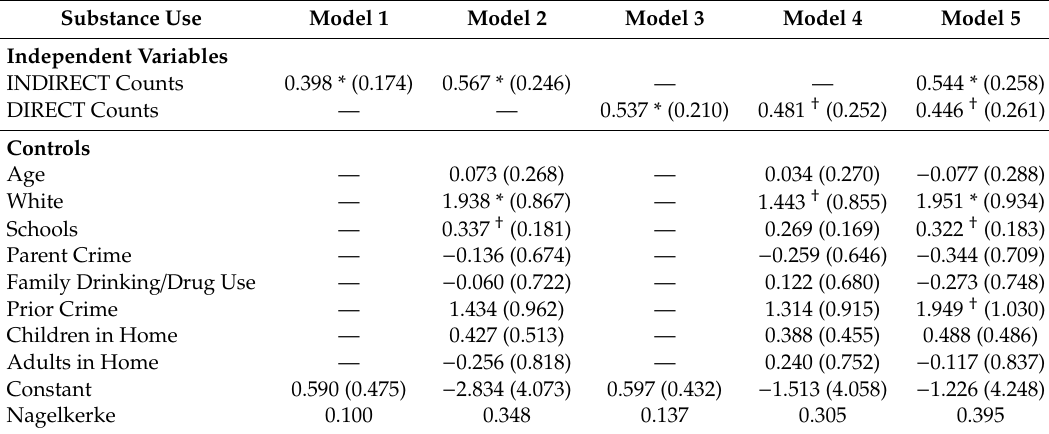
Table 2. The e ff ect of indirect and direct victimization counts on substance use.